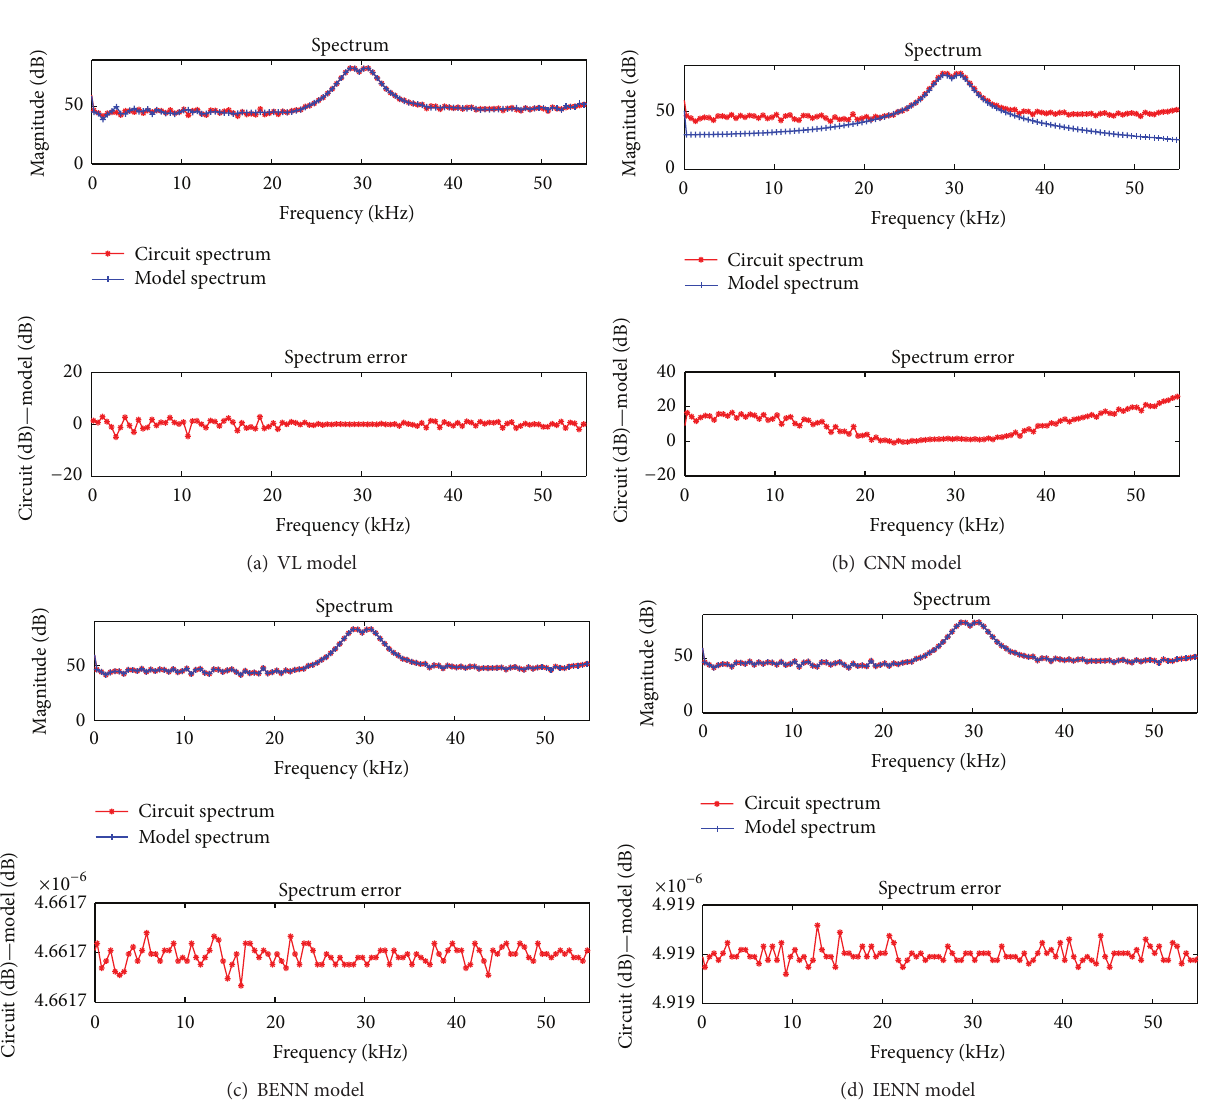
Figure 8: Comparison among four behavioral models in frequency domain with LFM signal input.